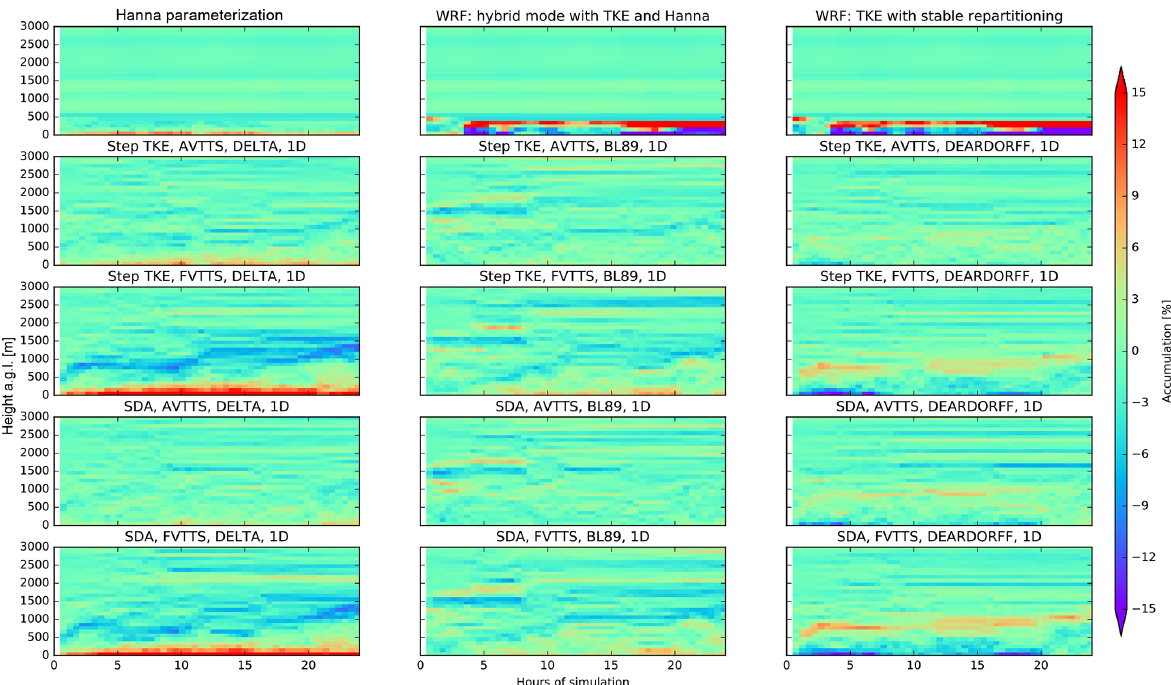
Figure 4. The vertical profile of accumulation in a well-mixed test from all the different turbulence configurations in FLEXPART-AROME is shown throughout the 24h simulation test. These tests were run in a single column over the ocean